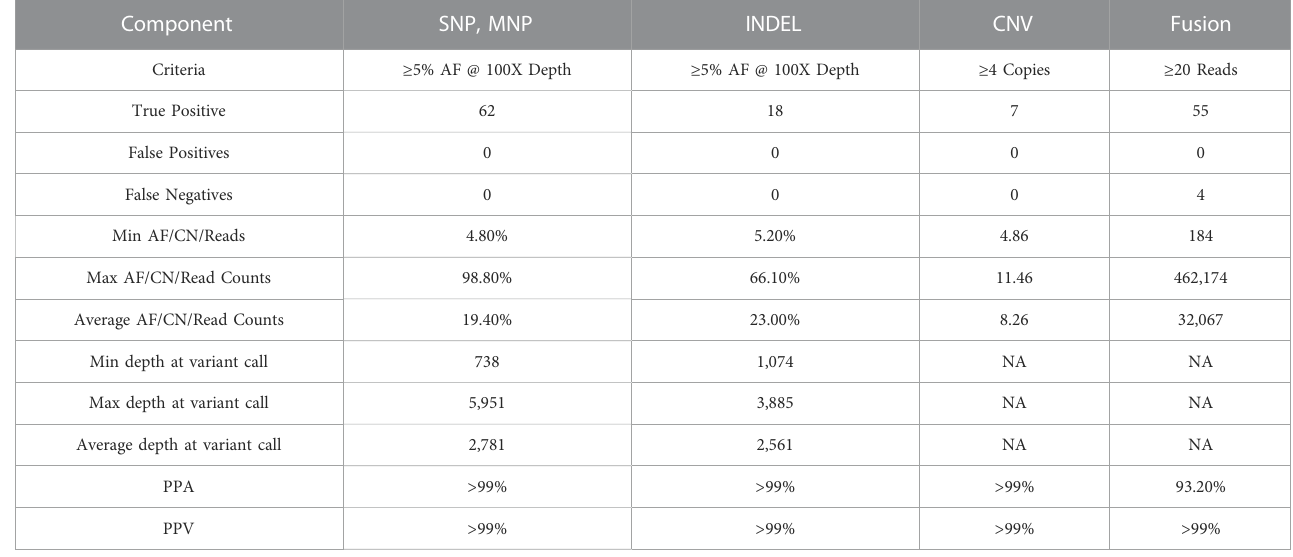
TABLE 11 Accuracy. Overall PPA and PPV of different variant types.